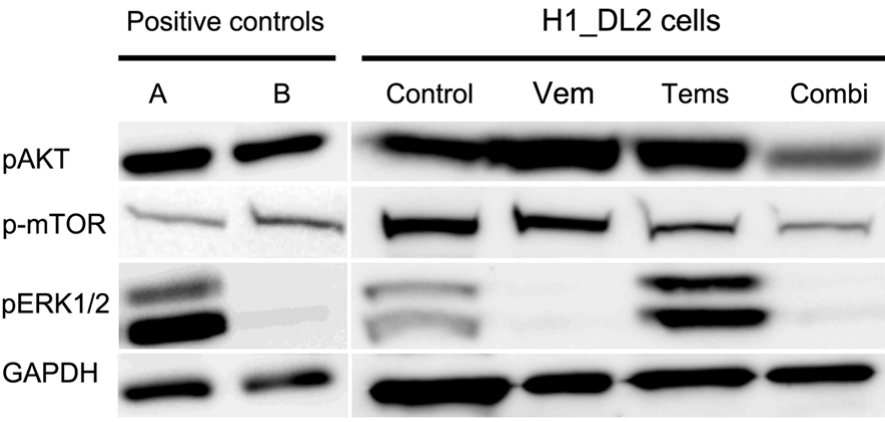
Figure 4. Western blot of H1_DL2 cells after drug treatment with vemurafenib and temsirolimus. Western blot of phosphorylated ERK1 and phosphorylated